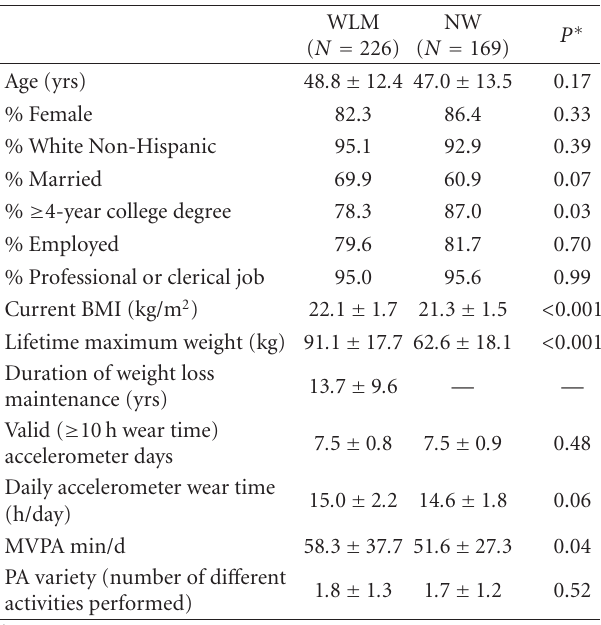
Table 1: Characteristics of weight loss maintainer (WLM) and always normal-weight (NW)